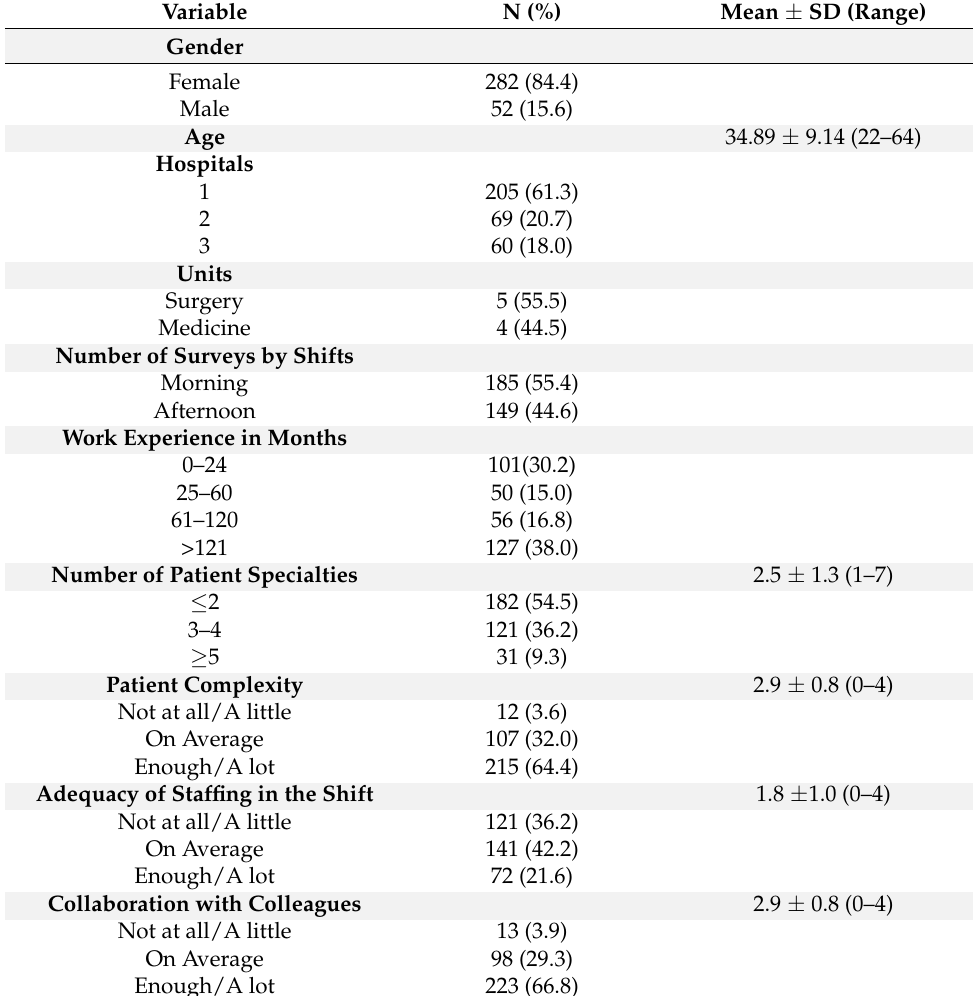
Table 1. Descriptive characteristics of the sample and variables studied (N =